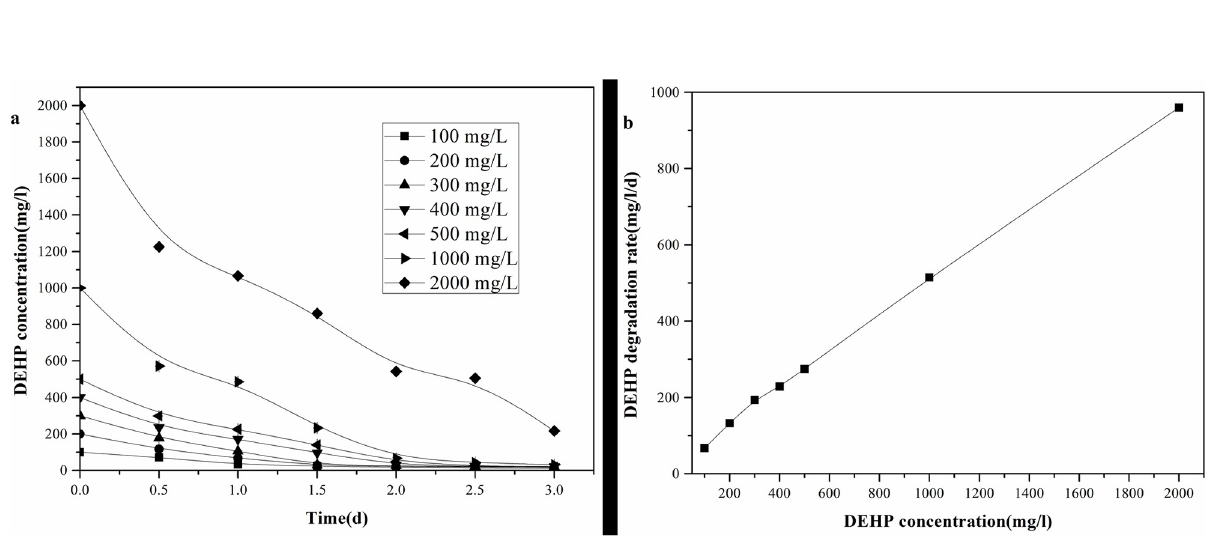
Fig 5. DEHP degradation kinetics (a) DEHP degradation; (b) DEHP degradation rate on the first day.